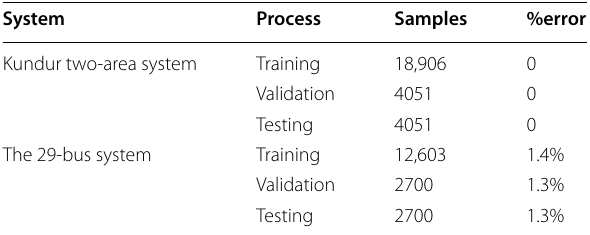
Table 5 Performance of the developed machine model on the Kundur two-area and the 29-bus systems System